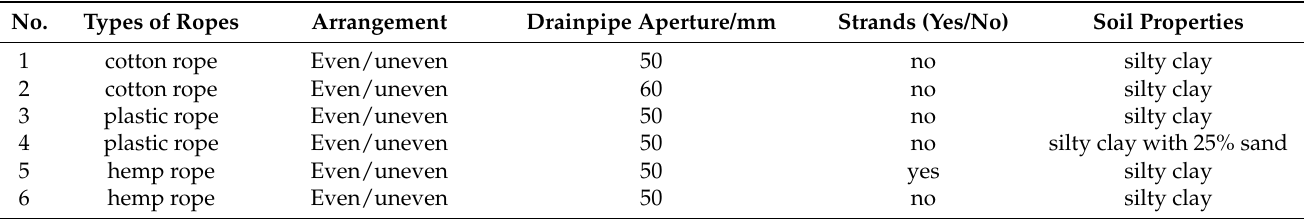
Table 5. A design table of the drainage performance test program of the fiber bundle drainage pipe considering the influence of the drainage pipe diameters, soil properties and strand-shaped fiber bundles.